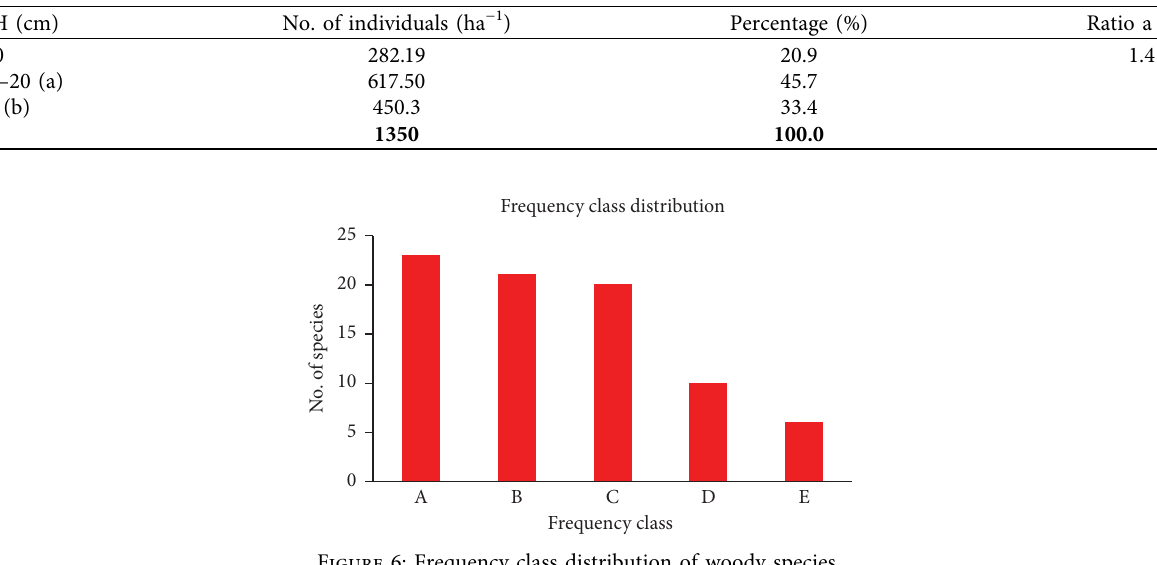
Table 8: Density of tree species by DBH classes in MFBR.